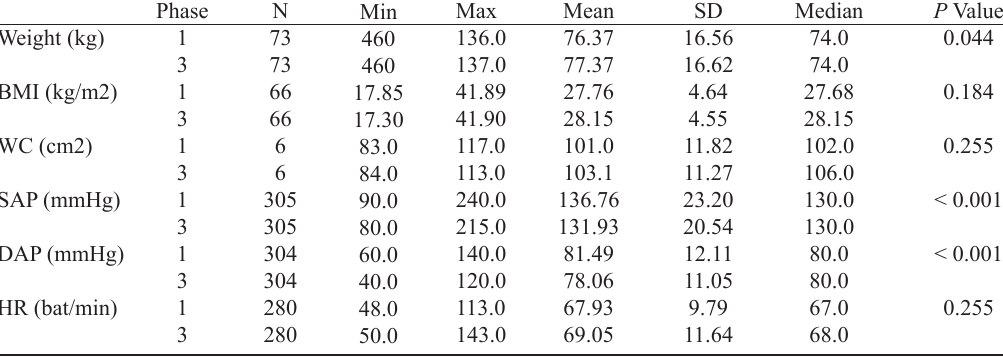
Table 6. Anthropometric